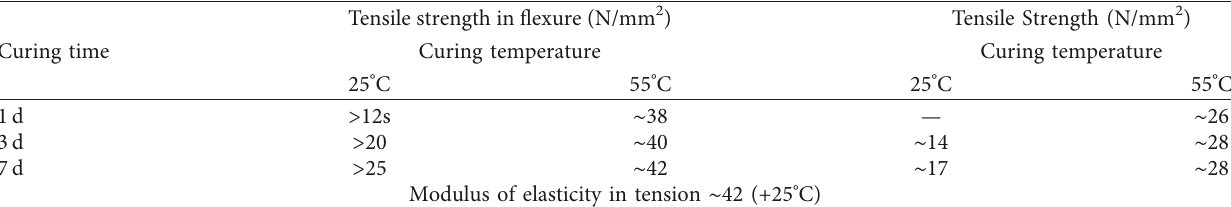
Table 3: Mechanical properties of Sikadur resin ∗ .